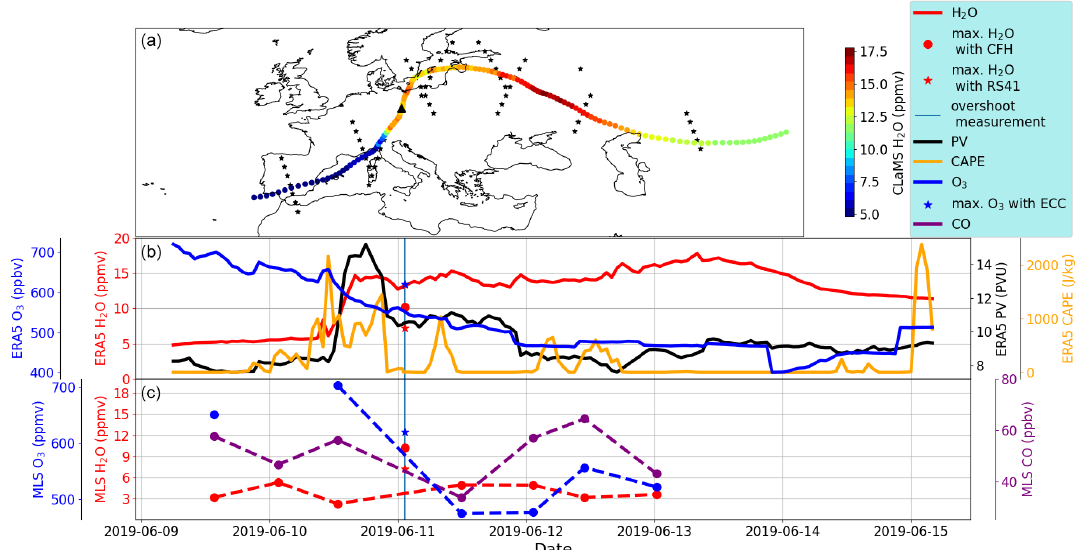
Figure 9. Trajectory of the measured air mass for case 1, with MLS data taken within 5 ◦ of latitude and longitude of the trajectory. Panel (a) shows the trajectory on a map, with the color-coded water vapor mixing ratios along the trajectory. Additionally, all MLS data points within a longitude and latitude of 5 ◦ , as well as within 1h before and after the individual trajectory points, are shown as star symbols. In panel (b) , the water vapor from ERA5 along the trajectory is displayed in red, ozone in blue, PV in black, and CAPE in orange. The time of the measurement and the observed maximum water vapor mixing ratio from CFH and RS41 within the pressure levels of 145 and 165hPa are shown at the vertical blue line and with blue and red symbols, respectively. Panel (c) displays the same time frame, with the nearest MLS measurements of ozone in blue, water vapor in red, and CO in purple, within a radius of 300km of each trajectory point and 1h before or after the trajectory point.